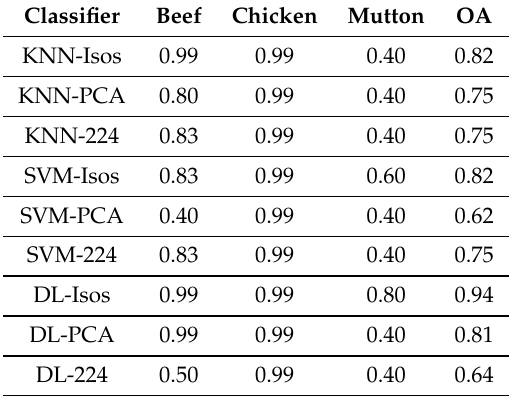
Table 3. The overall accuracy (OA) achieved by each classifer. Classifier Beef